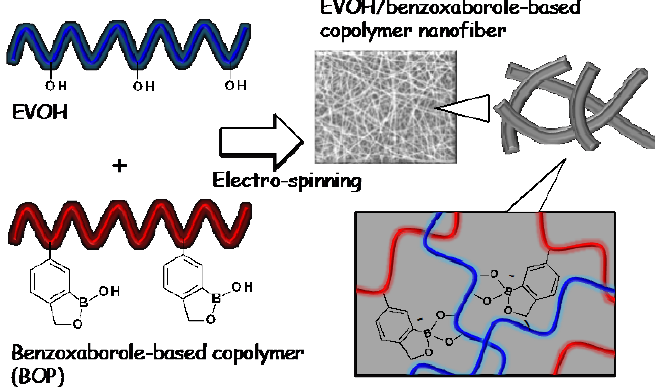
Figure 1. Schematic representation of modified EVOH nanofiber with benzoxaborole-based copolymers (BOPs).